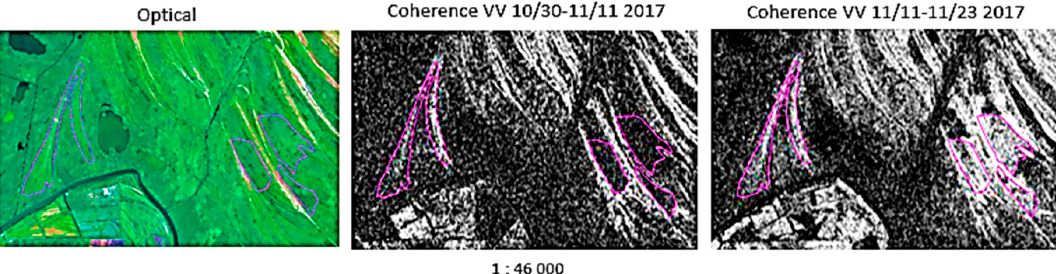
Figure 8. Reed cut identification (in purple) by visual interpretation of coherence images (November 2017). RGB bands combination for the optical